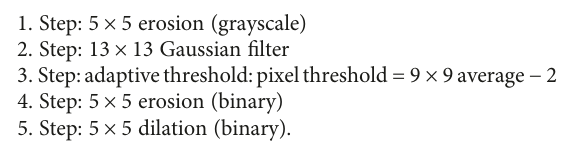
Algorithm 1. Preprocessing .